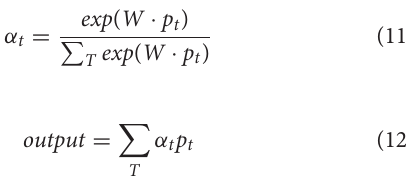
Bi-GRU layer. Based on the different importance of each frame is combined with the Bi-GRU structure, which is shown in Figure 9